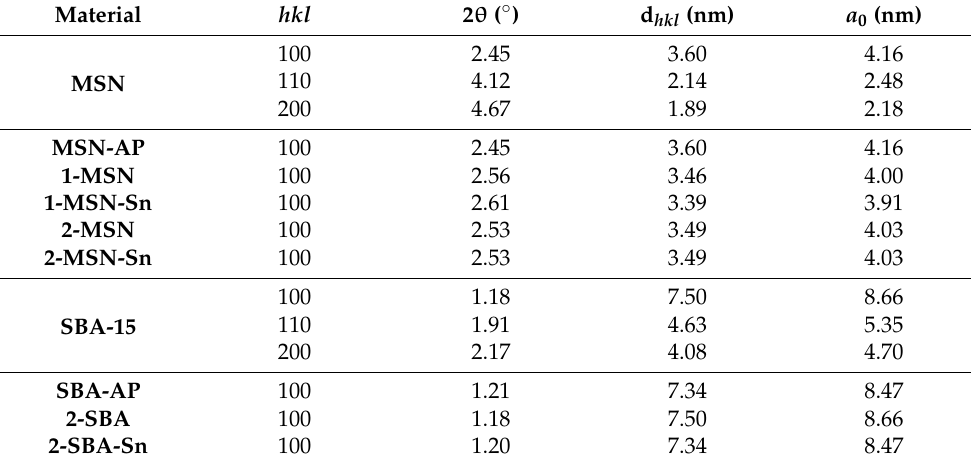
Figure 2. XRD diffractograms of ( a ) MSN -based and ( b ) SBA-15 -based materials. Table 3. XRD data of MSN , SBA-15 and all their functionalized materials.